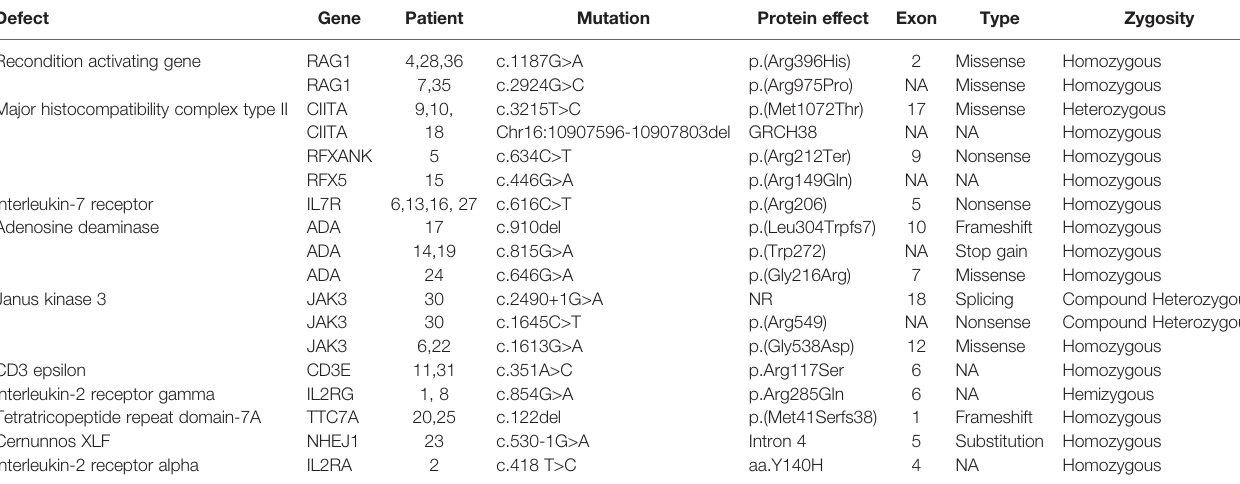
TABLE 3 | Genotype summary of 36 children with